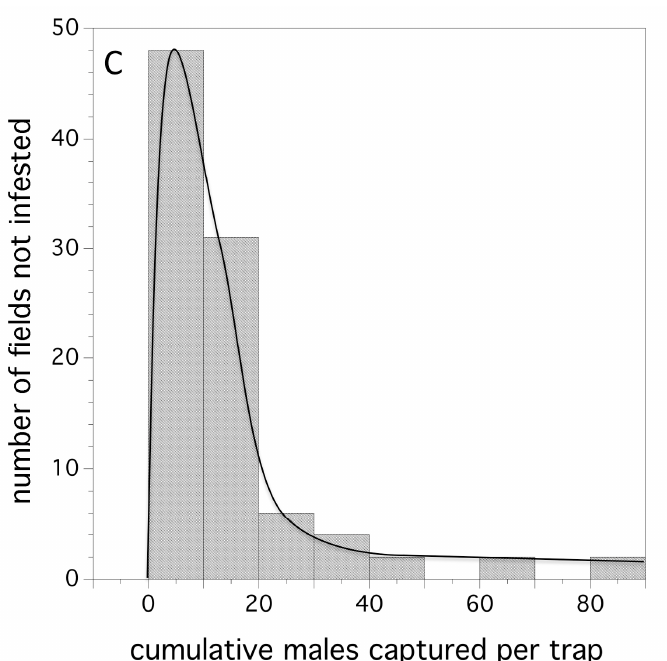
Table 6. Validation of action thresholds in commercial wild blueberry fields (2016 – 2018).